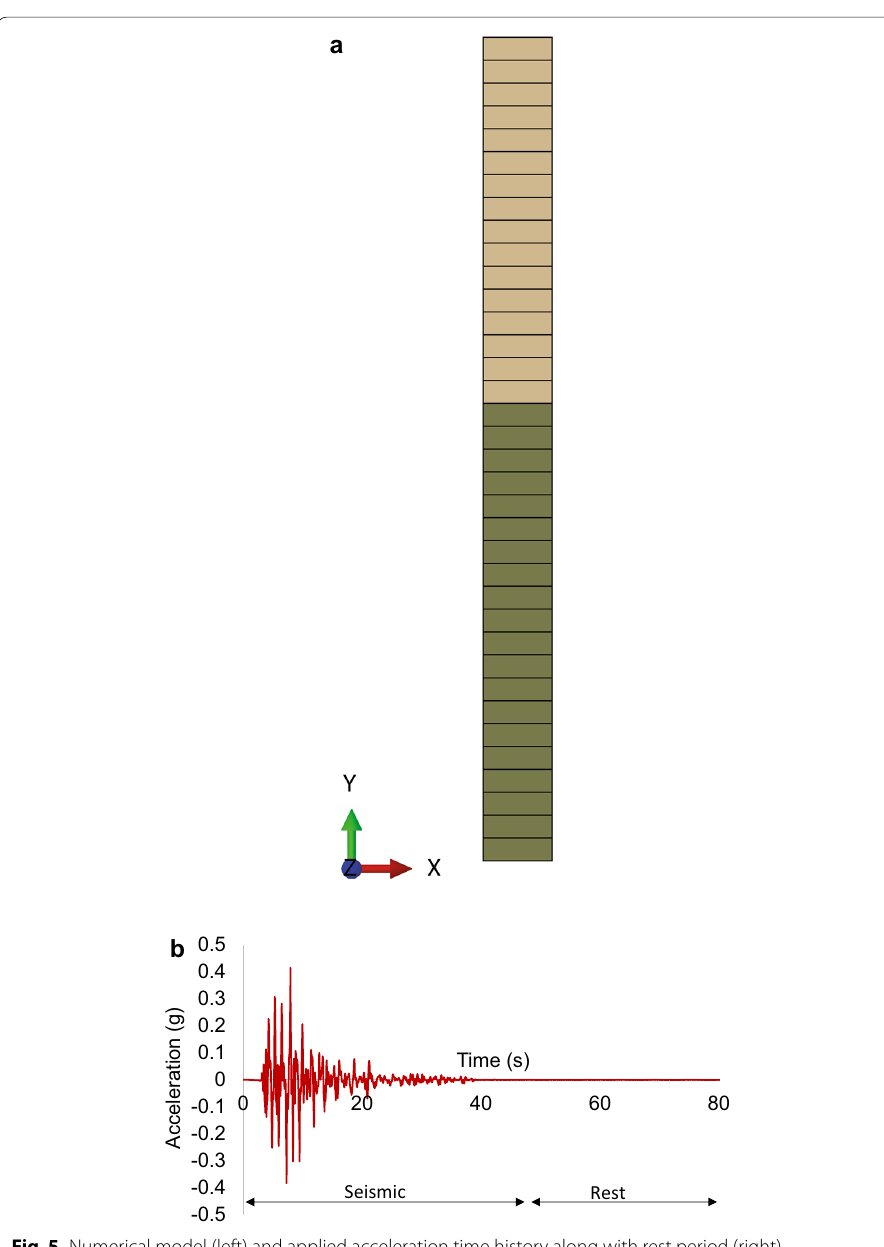
Table 2 Hypoplastic material properties of Ottawa F65